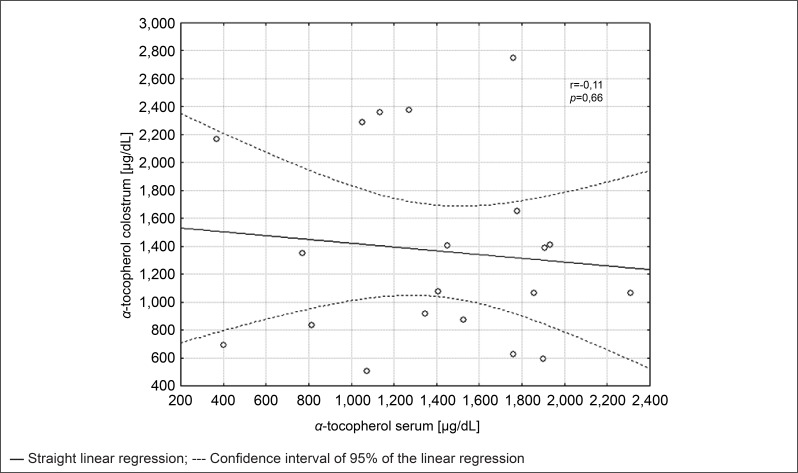
Correlação entre a concentração de a-tocoferol no soro e no colostro de
lactantes do Grupo de Diabetes Melito Gestacional